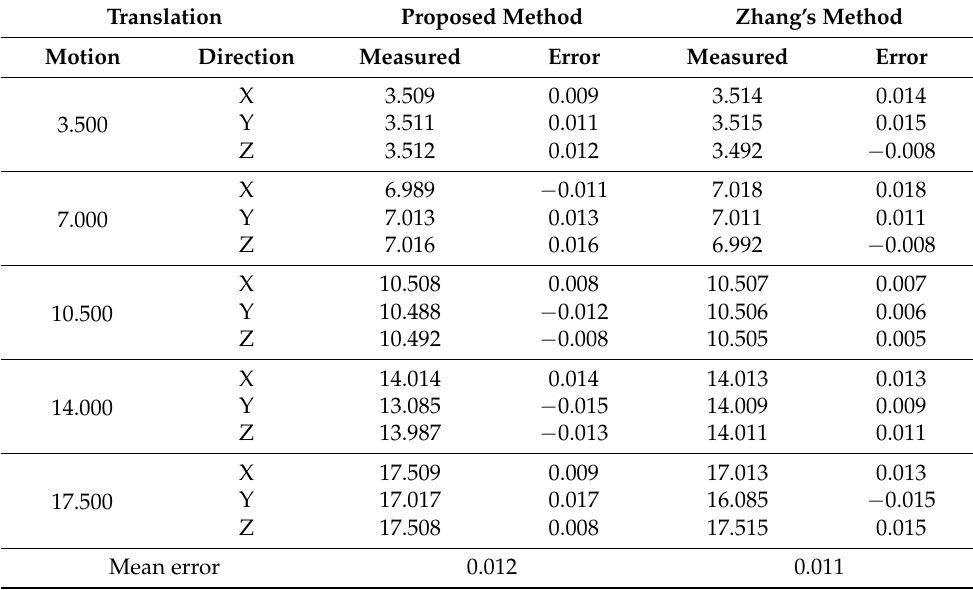
Table 3. Measured displacement of the feature point (unit in